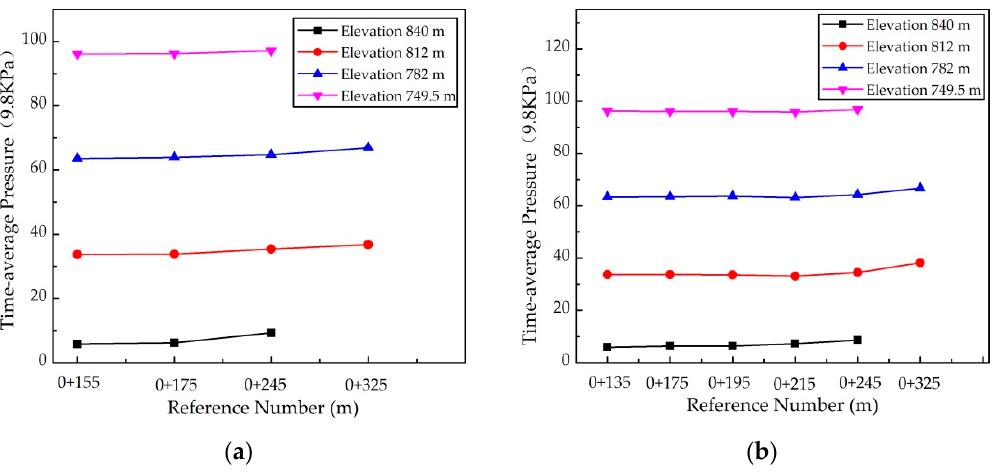
Figure 6. The distribution of Time-average pressures on the slope lining under operating Condition 1. ( a ) left slope; and ( b ) right slope.